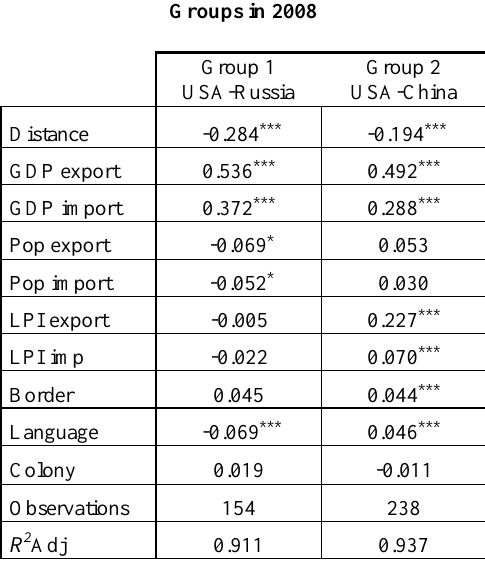
Table 5: Estimated Coefficients for